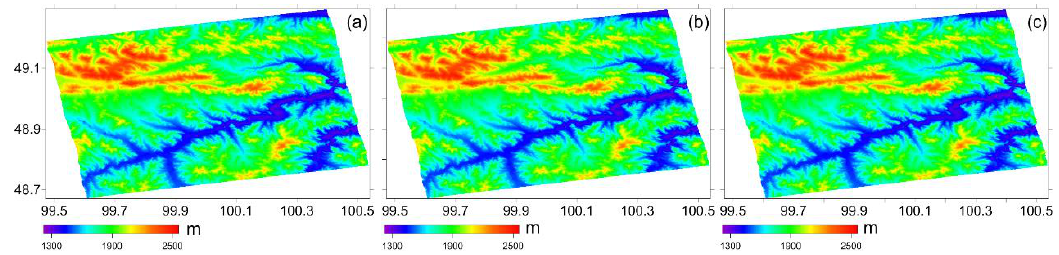
Figure 15. InSAR DEM ( a ) without atmospheric correction; ( b ) with Shirzaei’s atmospheric correction method; and ( c ) with MRWCA atmospheric correction.